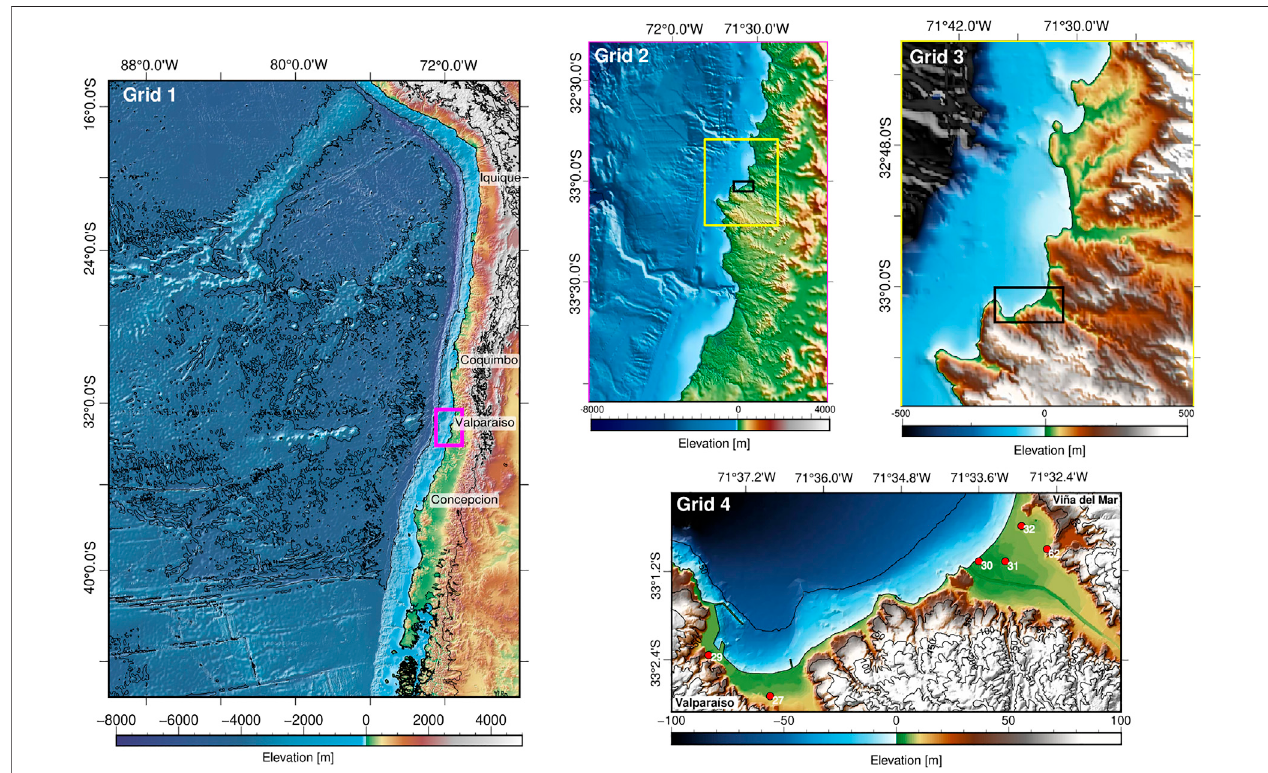
FIGURE3| Nesteddigitalelevationmodelsusedinthenumericalsimulations.Thecolorbarstandsfortheterrainelevationwithresolutionsof30arcsec(grid1),7.5 arcsec (grid 2), 1.875 arcsec (grid 3) and 0.234 arcsec (grid 4). Red points show the points of interest where tsunami arrival times are analyzed.